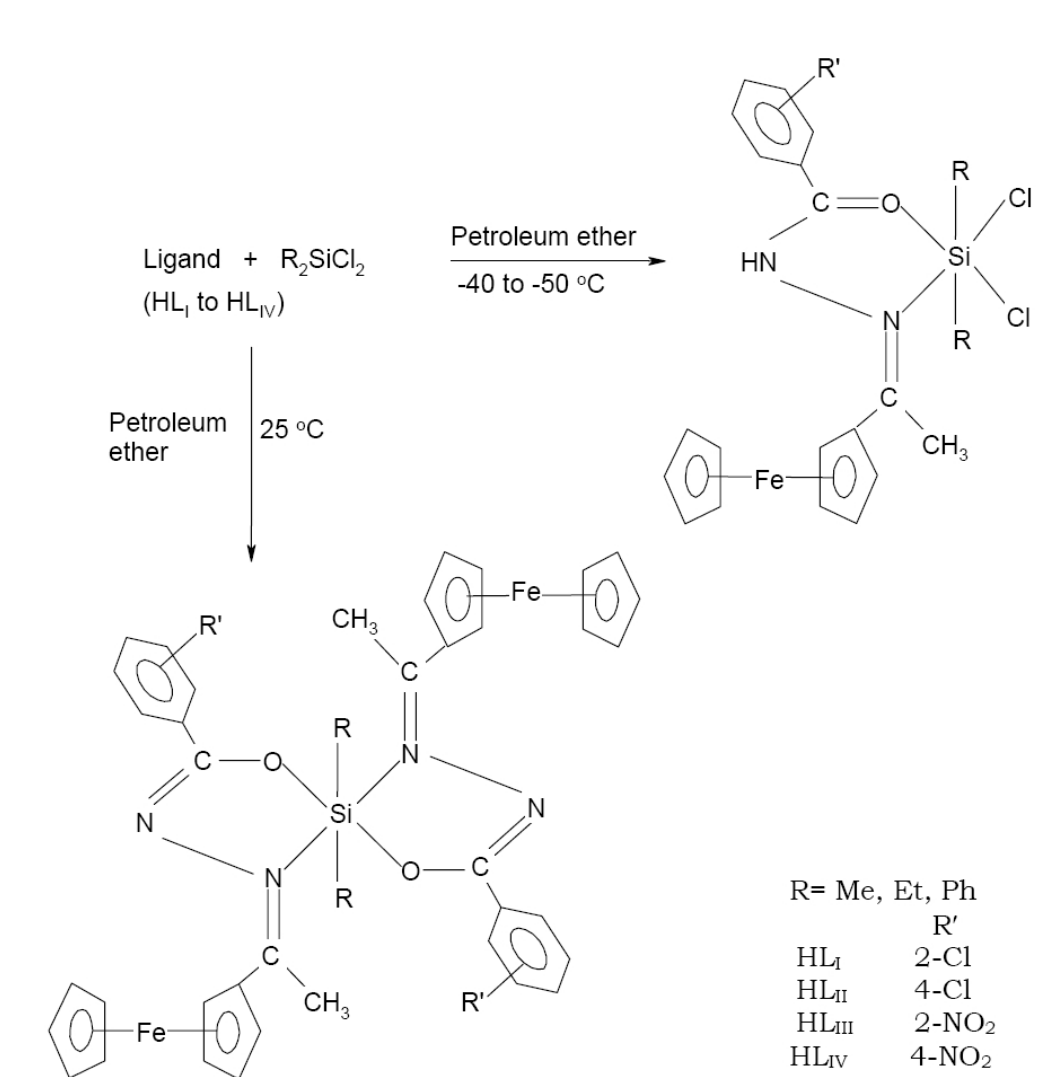
Fig. 1 Organosilicon complexes at different